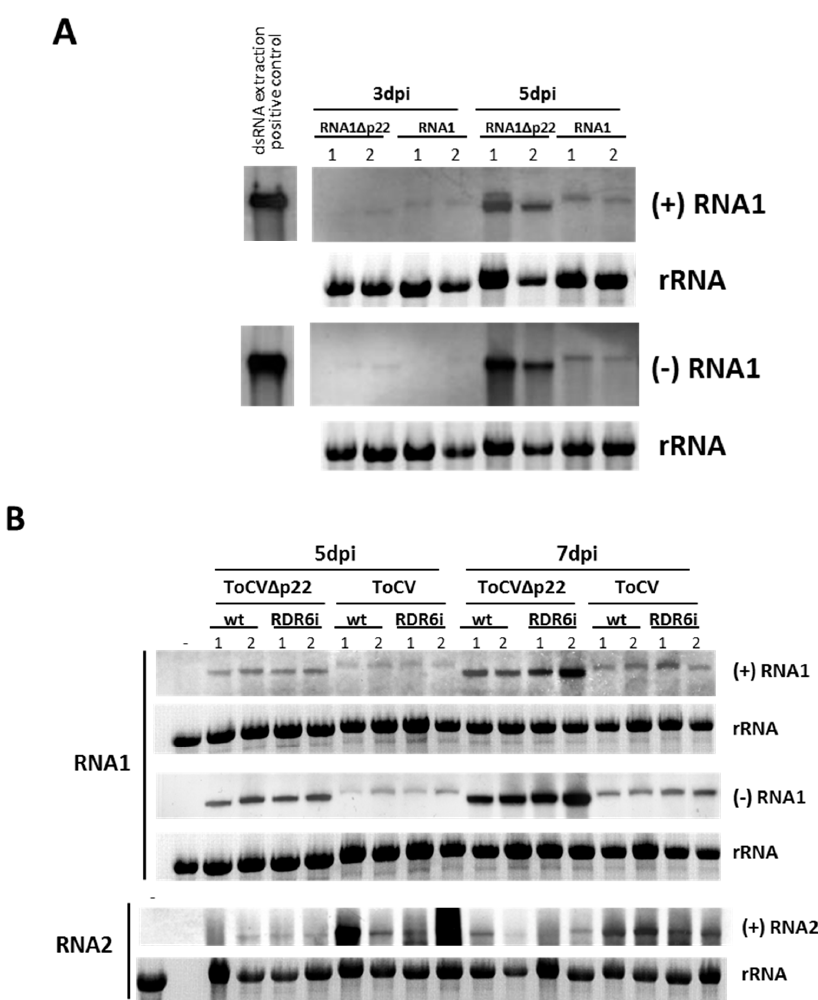
Figure 2. Northern blot analysis using digoxigenin (DIG)-labelled RNA probes to detect the positive (+) or negative ( − ) sense RNA forms during local infection with wild-type or p22 mutant Tomato chlorosis virus (ToCV) (ToCV and ToCV Δ p22, respectively). ( A ) Local RNA1 replication and accumulation of (+) and ( − ) sense strands [(+) RNA1 and ( − ) RNA1] at 3 and 5 dpi in patches of wild-type Nicotiana benthamiana agroinfiltrated with RNA1 infectious clones of ToCV or ToCV Δ p22. As a positive control, a dsRNA extraction from a ToCV infected plant was used; ( B ) Local replication and accumulation of (+) and ( − ) sense strands [(+) RNA1 and ( − ) RNA1] of RNA1, and accumulation of (+) strand [(+) RNA2] of RNA2 at 5 and 7 dpi in patches of wild-type and RDR6i N. benthamiana plants agroinfiltrated with infectious clones of RNA1 of ToCV or ToCV Δ p22 and RNA 2 of ToCV. Samples from two independent plants (1,2) were analysed. Ethidium bromide-stained rRNA was used as loading control.